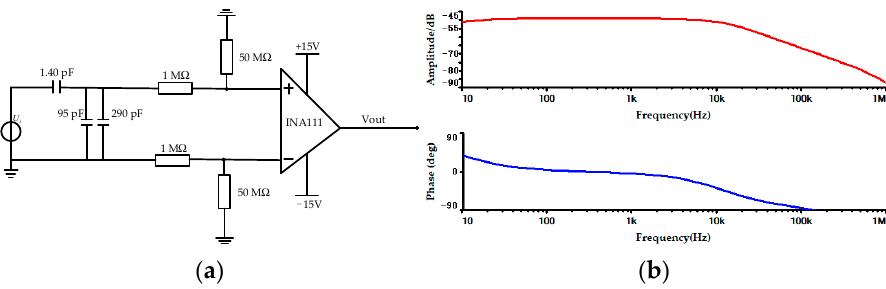
Figure 14. Measurement system equivalent model: ( a ) sensor measurement system equivalent circuit; ( b ) frequency response curve. Table 2. Low voltage performance test input/output voltage and ratio error calculation results.